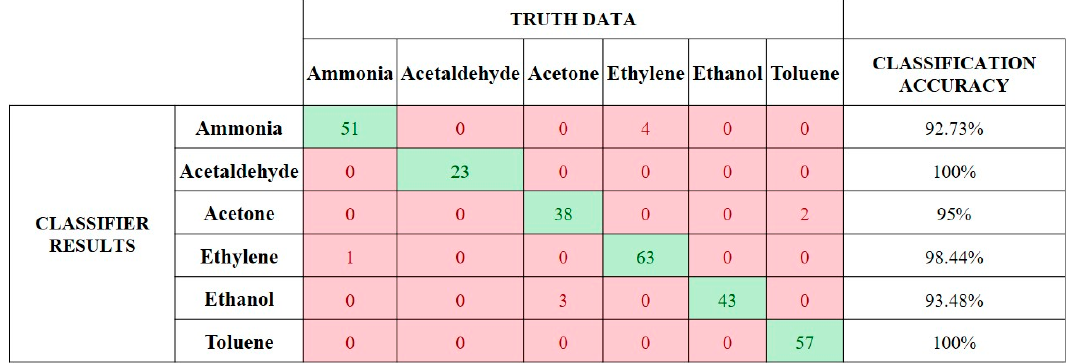
Figure 7. Confusion matrix showing classifier accuracy for [20] dataset .